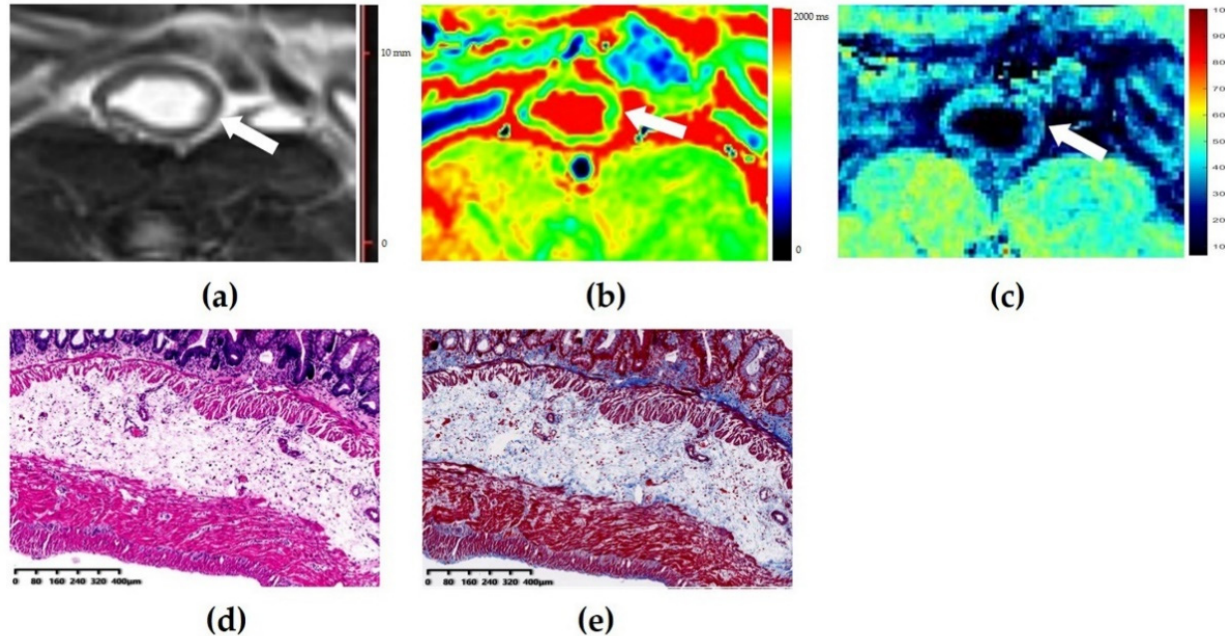
Figure 4. Images of a mildly fibrotic and moderately inflamed bowel wall of a rat. ( a ) Axial T2-weighted imaging reveals a thickened bowel wall. ( b ) T 1 map shows that the T 1 value is 1304 ms (higher than the cutoff value of 1266 ms), thus